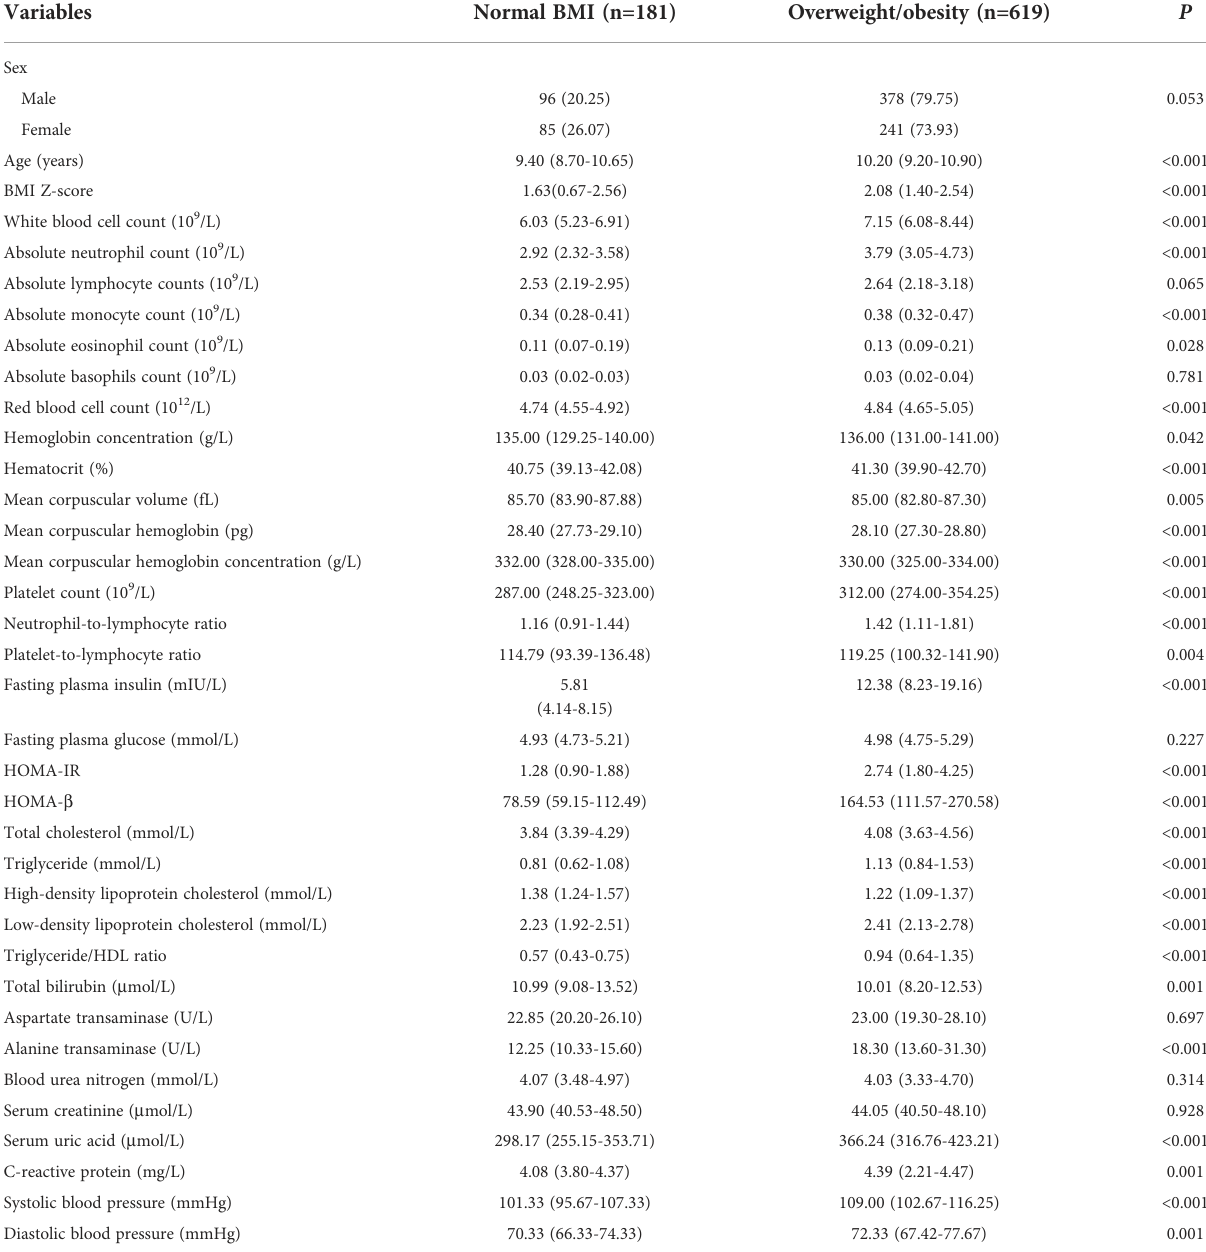
TABLE 1 Clinical characteristics of school-age children with normal BMI and